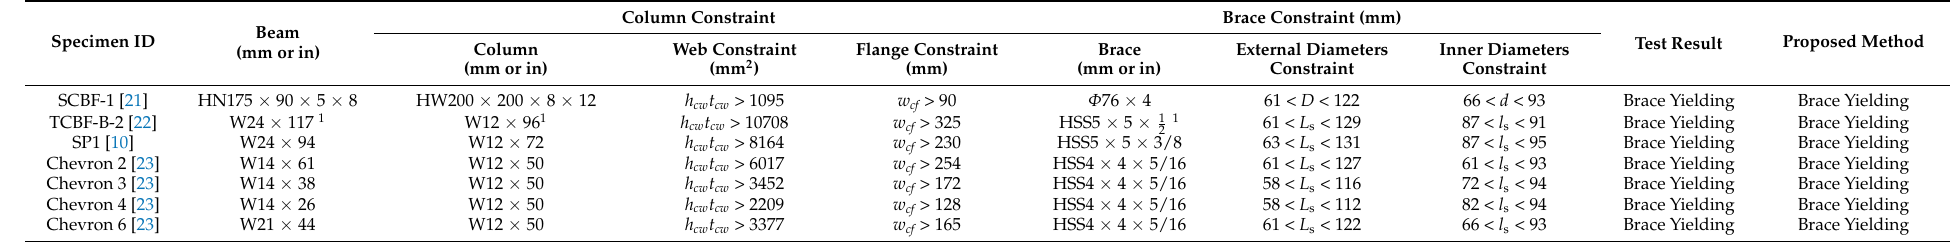
Table 2. Experimental verification results (top floor).